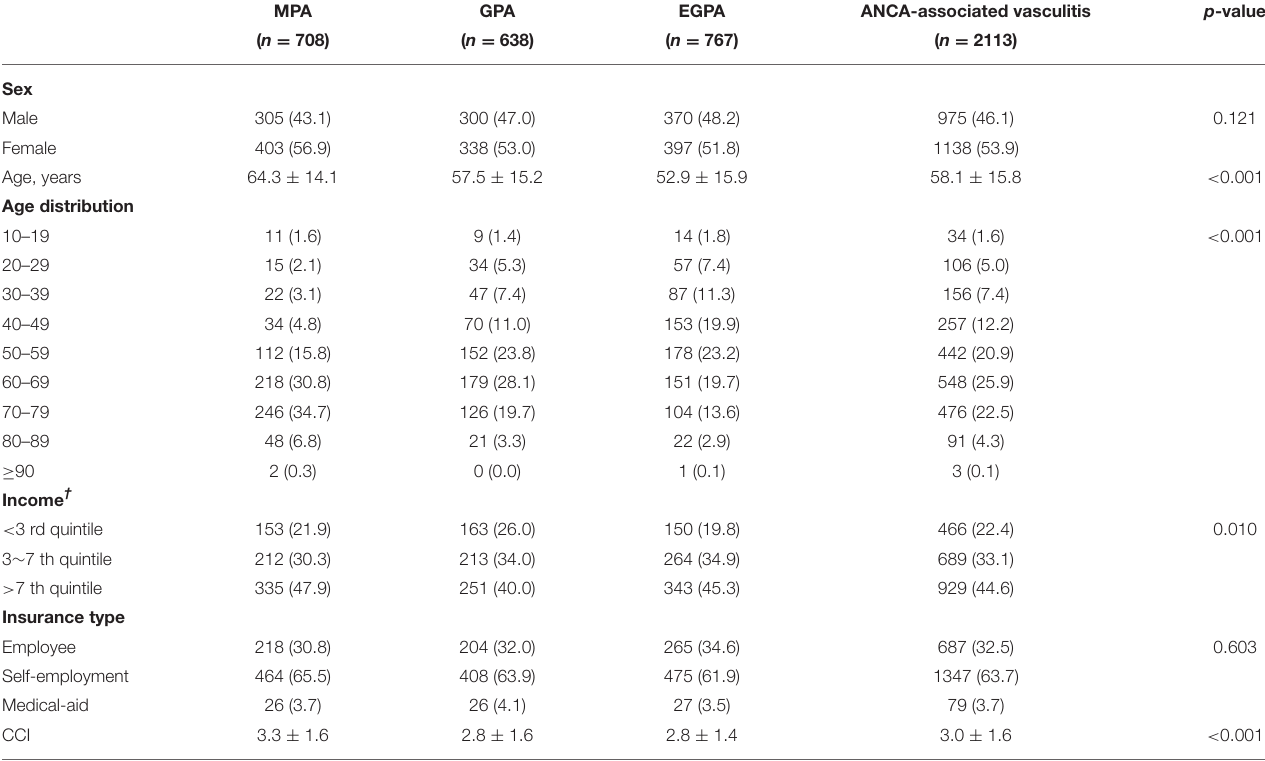
TABLE 2 | Comparison of characteristics between subgroup of patients with ANCA-associated vasculitis at diagnosis. MPA EGPA ANCA-associated